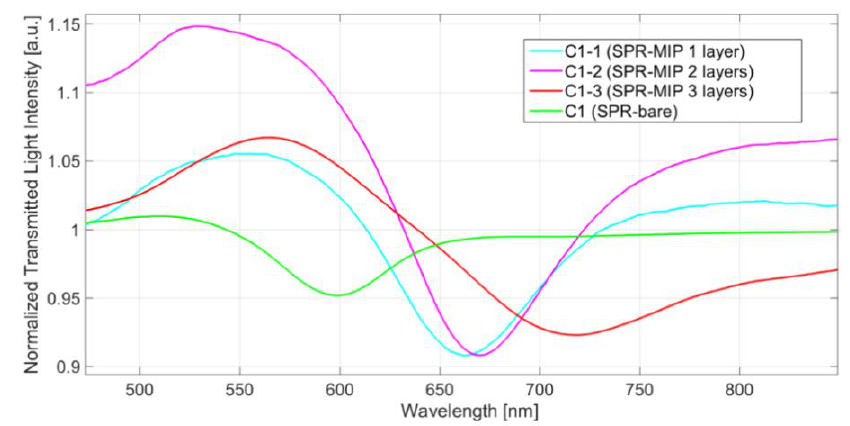
Figure 4. Transmission spectra of C1 (SPR-MIP) platform, with one, two, or three MIP layers, in water, normalized on the spectrum of the corresponding platforms in air. Table 1. Resonance wavelength of sensors with multiple MIP layers. Formation of each MIP layer: 40 µ L of prepolymeric mixture spun at 300 rpm. Normalization on the corresponding platform in air. Type of Sensor N. of MIP